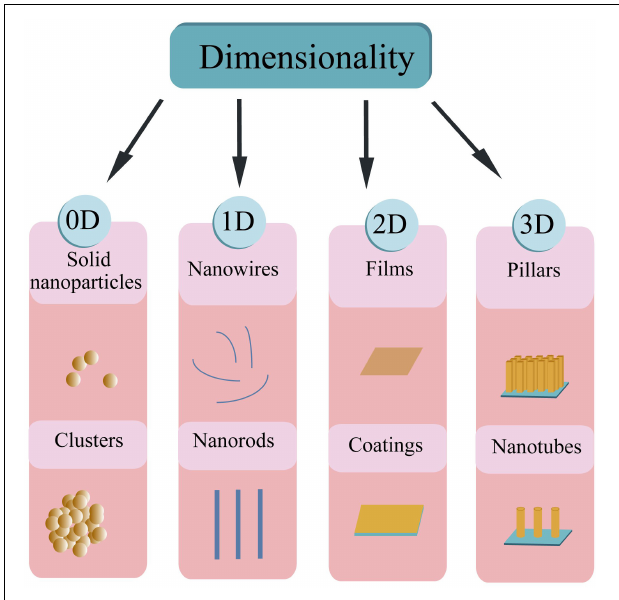
FIGURE 1 | Schematic illustration of the nanomaterial’s classification based on